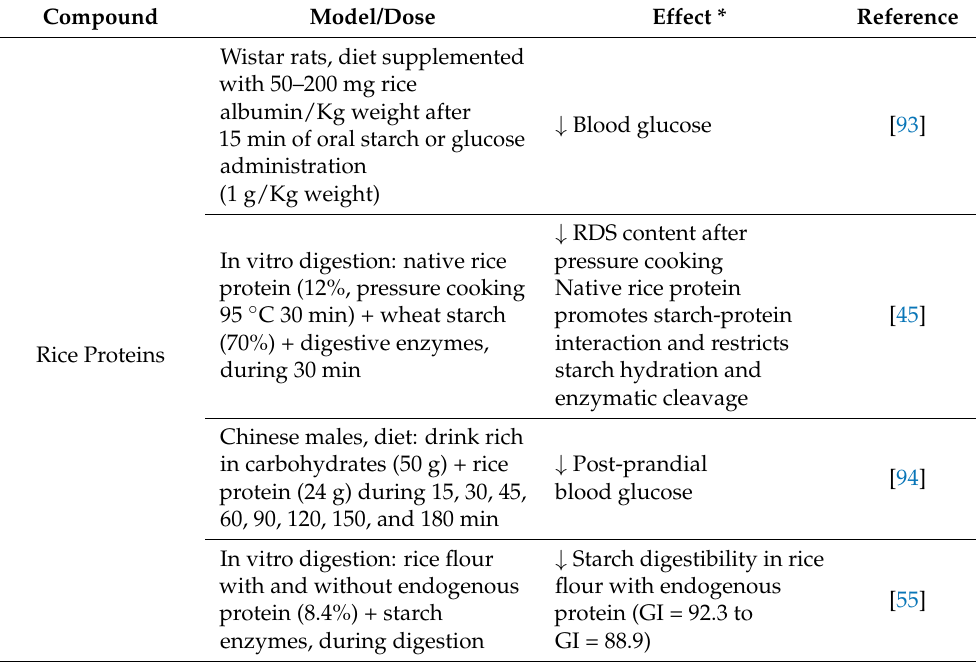
Table 4. Studies on the effect of macronutrients and bioactive rice compounds in the glycemic index of foods, blood glucose and insulin, and oxidative